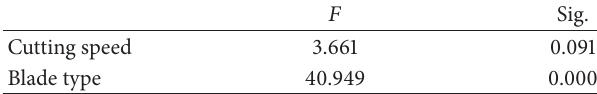
Table 5: 𝐹 test results—dependent variable: cutting force.